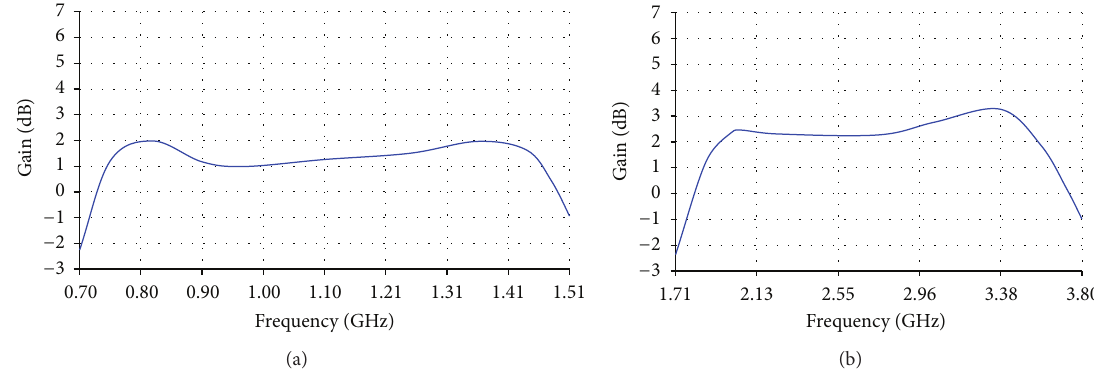
Figure 8: Gain of (a) the reduced size version of the low band antenna and (b) the reduced size version of the high band